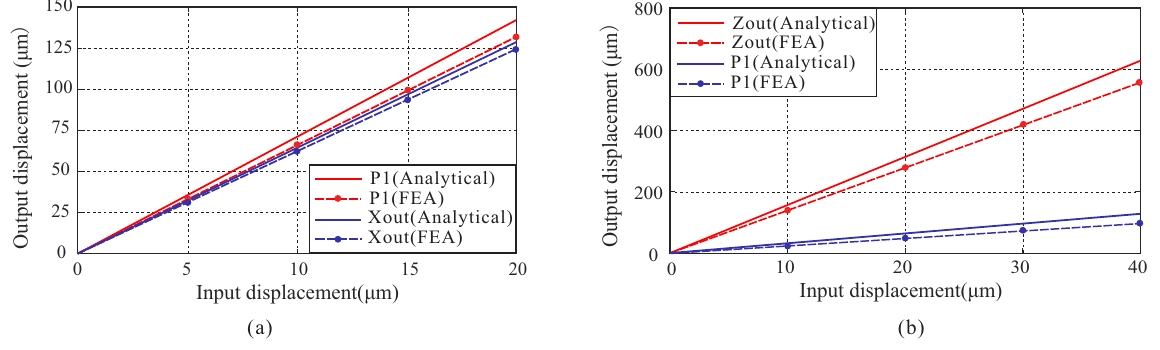
Figure 12. Relationship between the input displacement and output displacement: ( a ) only the left side of the X-axis applies input displacement; ( b ) both sides of X-axis have input displacements applied. The input stiffness and output stiffness are simulated by FEA and the comparisons between theoretical analysis and simulation results are shown in Table 4. The error of the input stiffness between the FEA and analytical model is only 8.07%. The error of output stiffness on the X-axis, Y-axis and Z-axis are 5.67%, 3.73% and 12.74 %. These errors are small enough to show that the theoretical analysis is right. The error of the output stiffness on the Z-axis is the largest compared to that on the X-axis and the Y-axis. It is mainly because the compliance matrix method does not take the large deformation of the hinges into consideration and the displacement on the Z-axis is larger than that on the X-axis